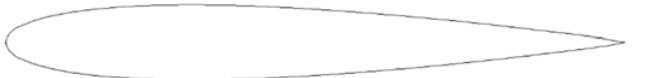
Figure 5. Fish body appearance model.